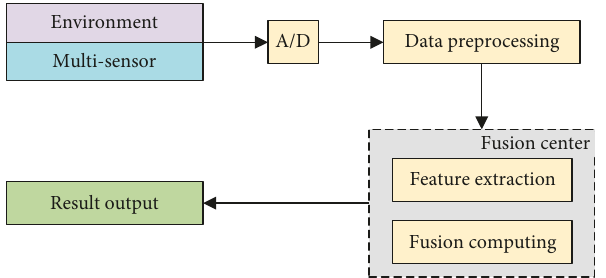
Figure 1: Flow chart of data fusion process.